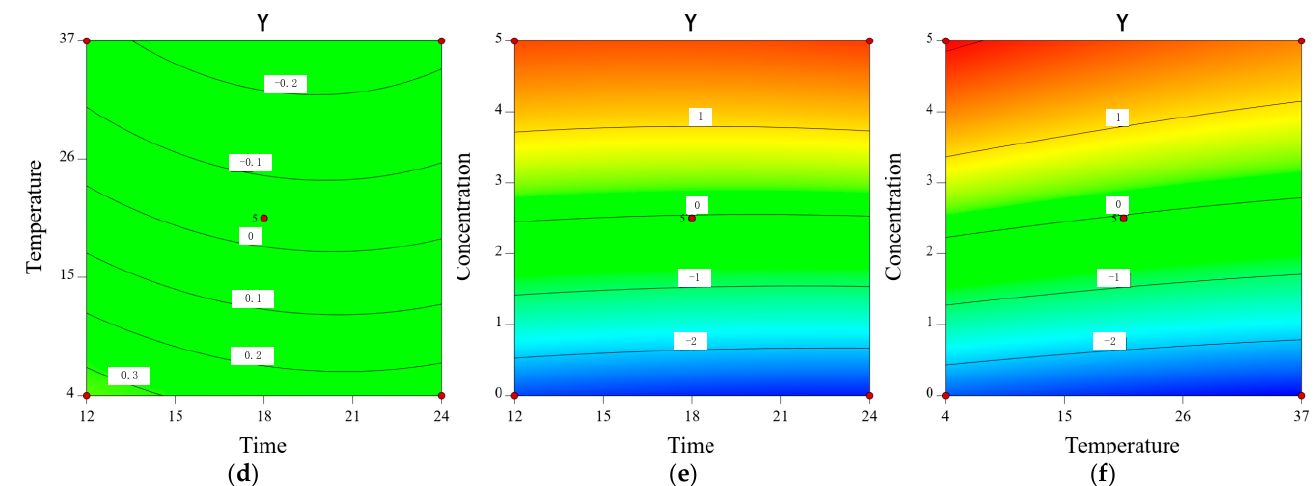
Figure 8. The contour plots showing the effect of interactions between ( a ) storage time and storage temperature, ( b ) storage time and CA concentration, and ( c ) storage temperature and CA concentration on E. sakazakii growth in skim milk. The response surface plots showing the effect of interactions between ( d ) storage time and storage temperature, ( e ) storage time and CA concentration, and ( f ) storage temperature and CA concentration on E. sakazakii growth in skim milk.